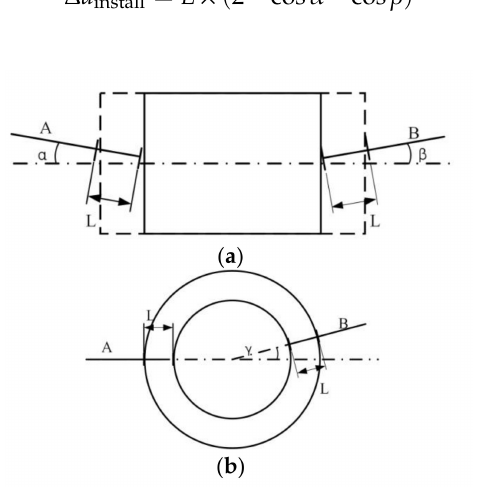
Figure 10. Error analysis in the horizontal plane. ( a ) Analytical model for rectangular wafer. ( b ) Analytical model for annular